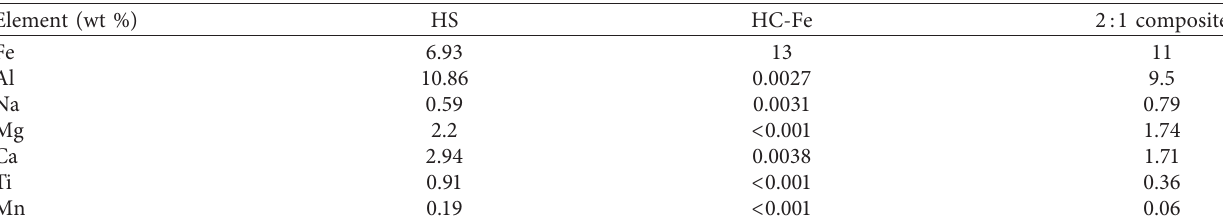
Figure 2: Photo-Fenton degradation of MB by different mass ratio HS/HC-Fe composite: [MB] � 50mg/L, [H [catalyst] � 2.5g/L under natural pH. Table 1: Composition of the HS, HC-Fe, and 2 :1